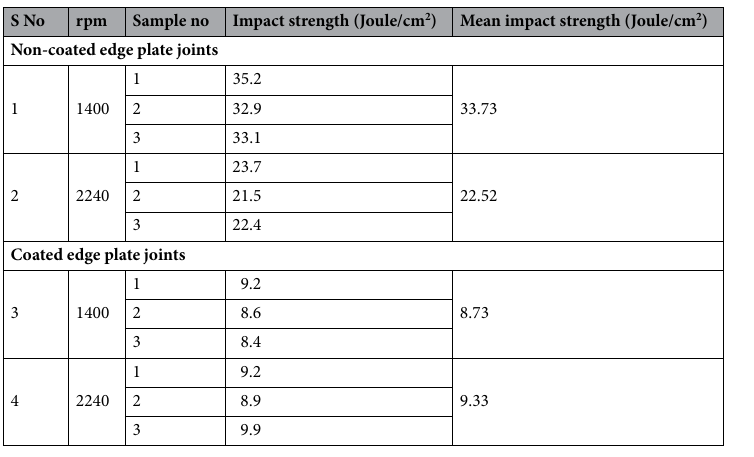
Table 3. Impact strength of